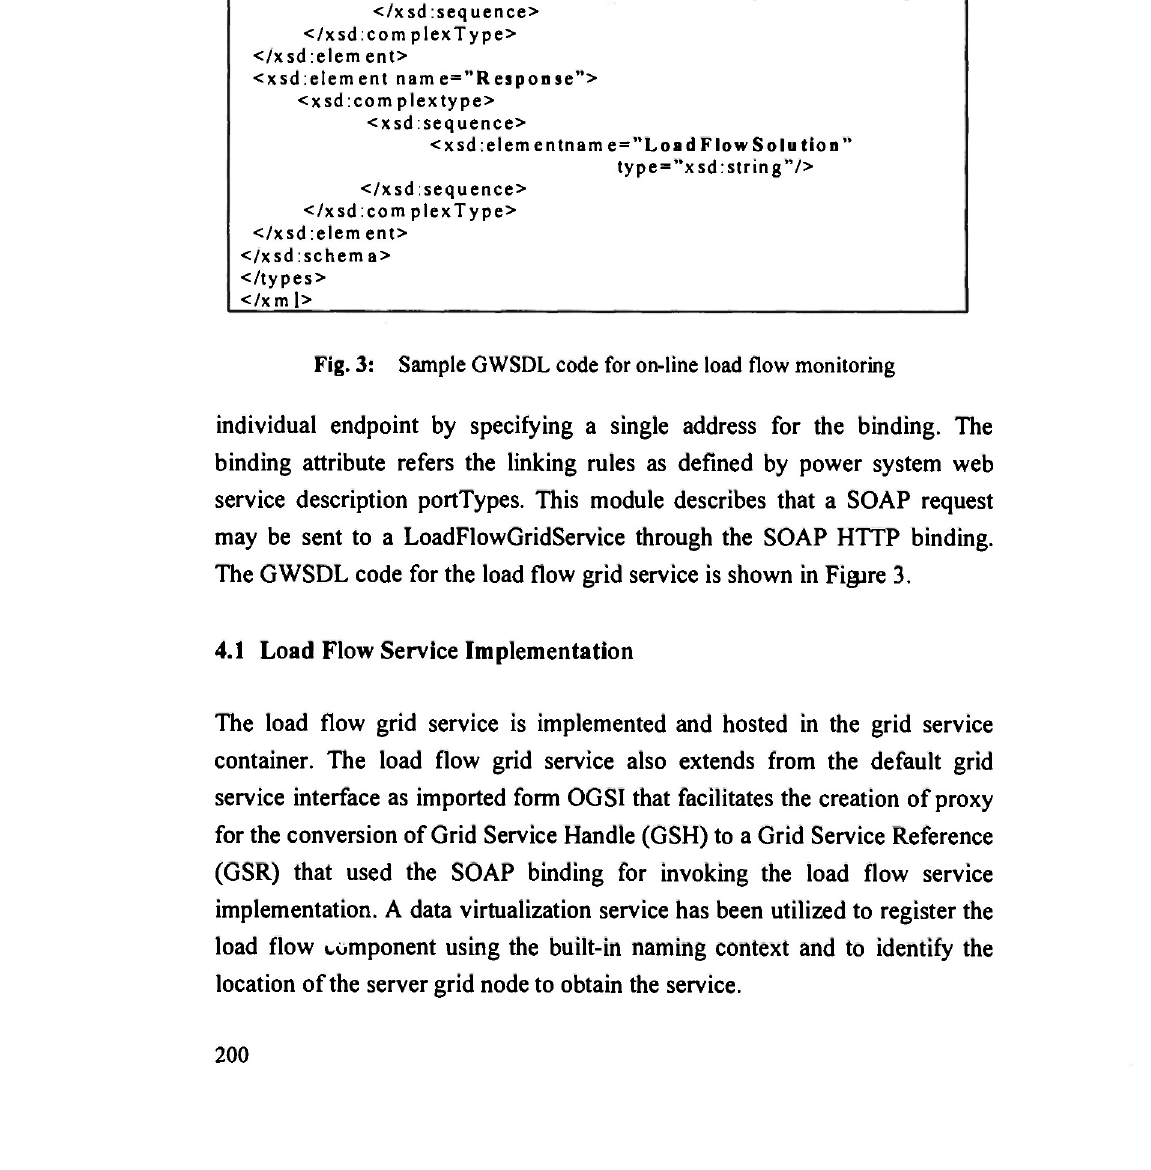
Fig. 3: Sample GWSDL code for on-line load flow